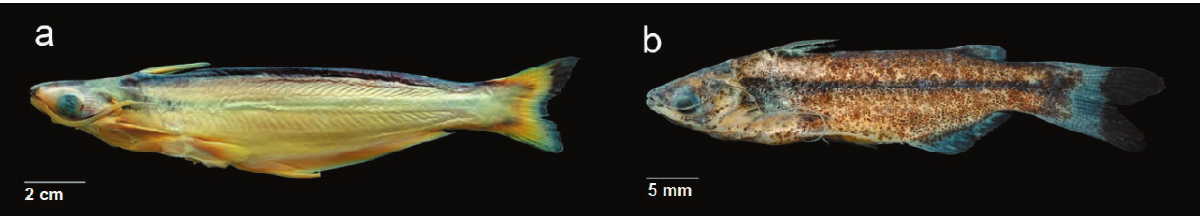
Figure 1. ( a ) Specimen of Auchenipterus nuchalis (Total length = 18.5 cm); ( b ) Specimen of Entomocorus radiosus (Total length = 4.96 cm).